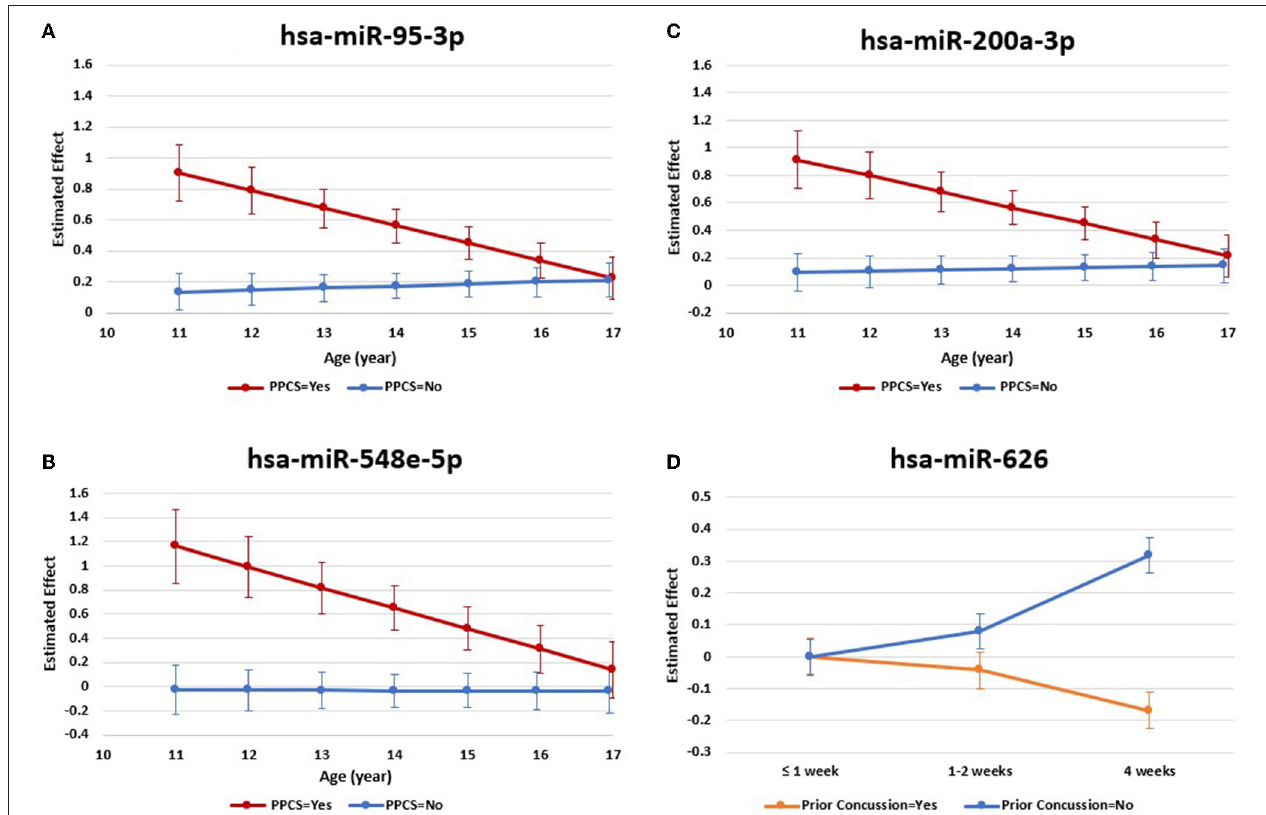
FIGURE 2 | miRNA expression levels with significant interactions post-injury. We found a statistically significant interaction between age and presence of PPCS in the expression levels of three miRNAs [ (A) hsa-miR-95-3p; (B) hsa-miR-548e-5p; (C) hsa-miR-200a-3p]. Results also revealed a statistically significant interaction between time and history of prior concussion in the expression levels of one miRNA ( D hsa-miR-626). These results were based on adjusted models in longitudinal